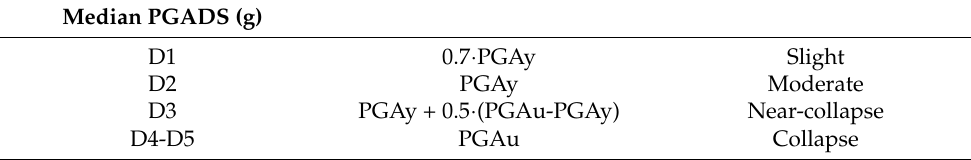
Table 3. Median thresholds, PGA DSi .